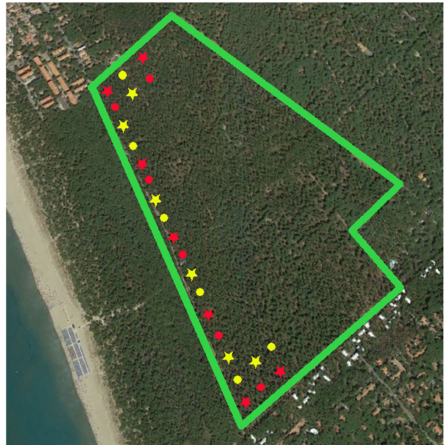
Figure 1. Study area with trap pattern as applied in 2019. Part of the coastal pine stands in the Municipality of Grosseto (Tuscany, Italy) is shown; the green line delimits the study area’s borders. Bait rotation alternated groups A (in red) and B (in yellow; symbols indicate modified (stars) and standard (circles)